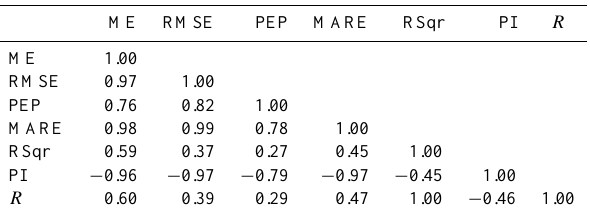
Table 3. Correlation matrix of individual statistics for experimental data series.